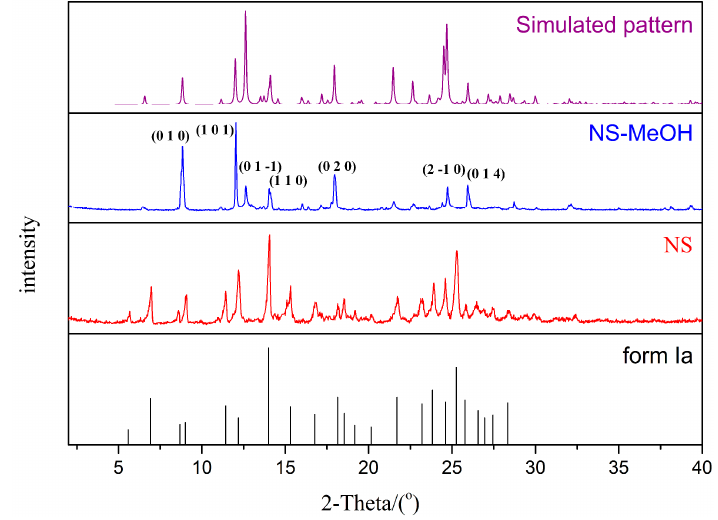
Figure 2. Powder X-ray diffraction (PXRD) patterns of form Ia, nicosulfuron (NS), NS-MeOH, and simulated pattern of NS-MeOH. Table 1. Crystallographic data of NS-MeOH and [[3-[(Dimethylamino)carbonyl]-2-